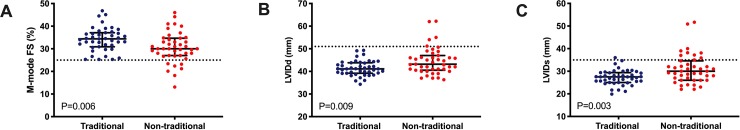
Results for echocardiographic variable differences for traditional and non-traditional diet groups.A) Unpaired t-test results for m-mode fractional shortening (FS) percent for different diet groups. The dashed line at 25% denotes the study threshold for a low FS. B) Mann-Whitney test results for left ventricular internal diameter in diastole (LVIDd) in mm for different diet groups. The dashed line at 51mm denotes the study threshold for diagnosing an increased LVIDd. C) Mann-Whitney test results for left ventricular internal diameter in systole (LVIDs) in mm for different diet groups. The dashed line at 35mm denotes the study threshold for diagnosing an increased LVIDs.